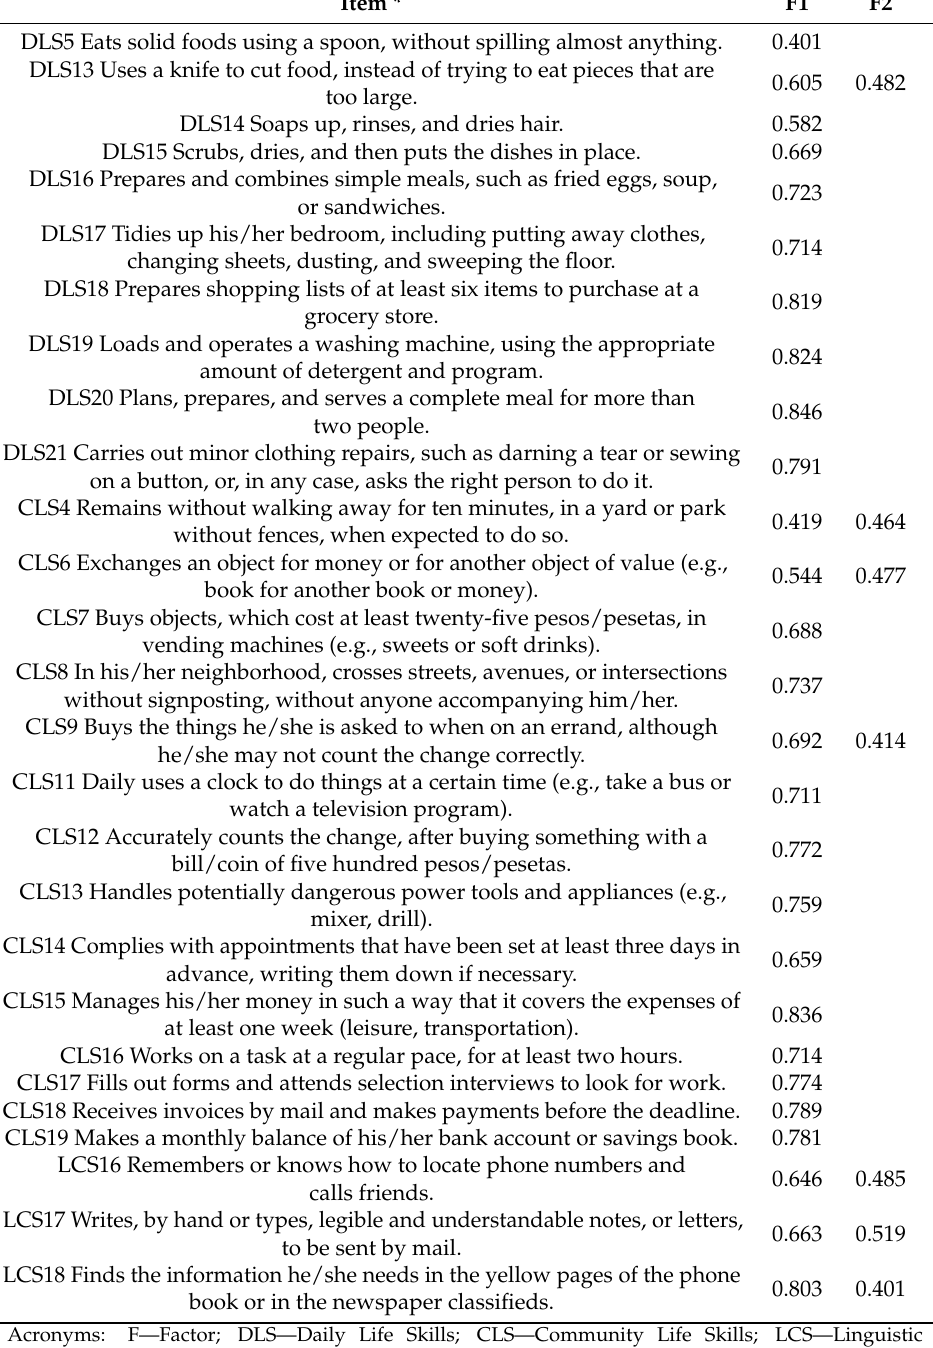
Table 3. Daily life skills dimension: items and factor load. Item *